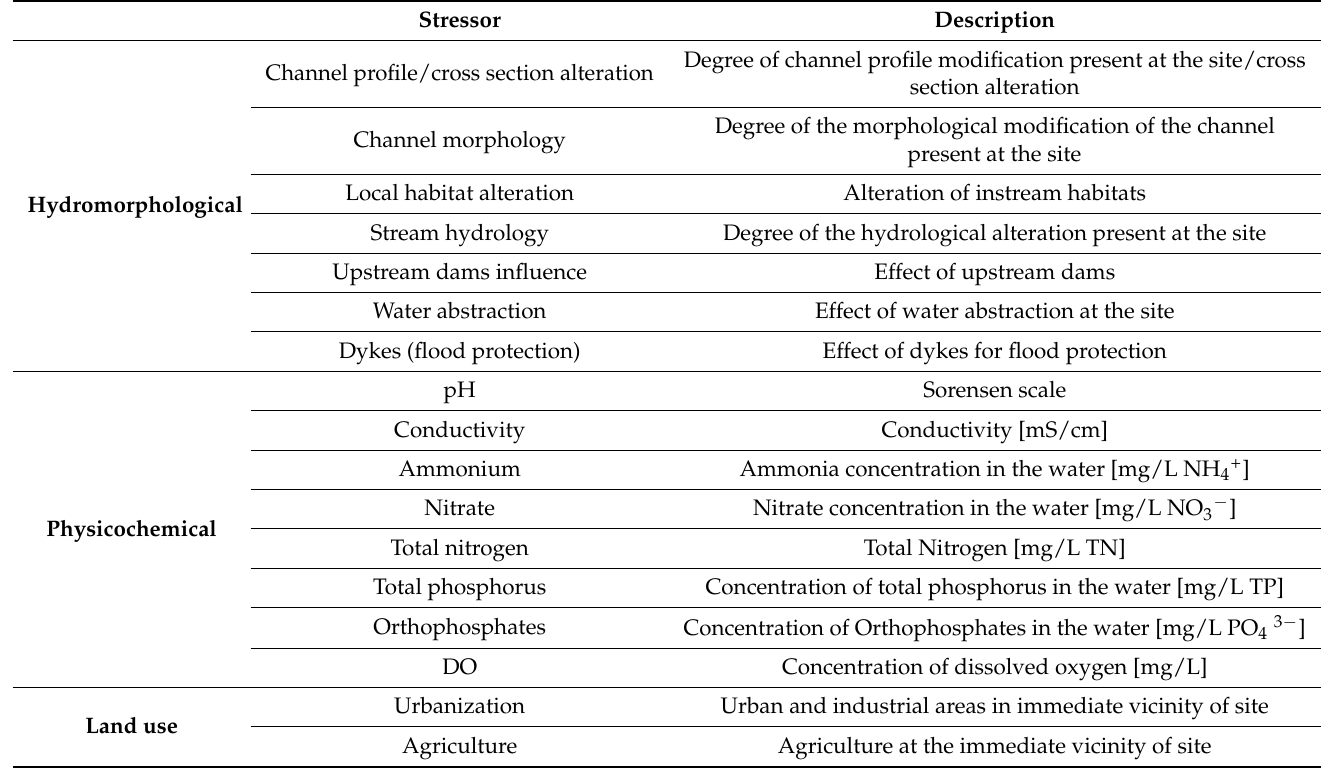
Table 1. Environmental variables that were considered as potential stressor